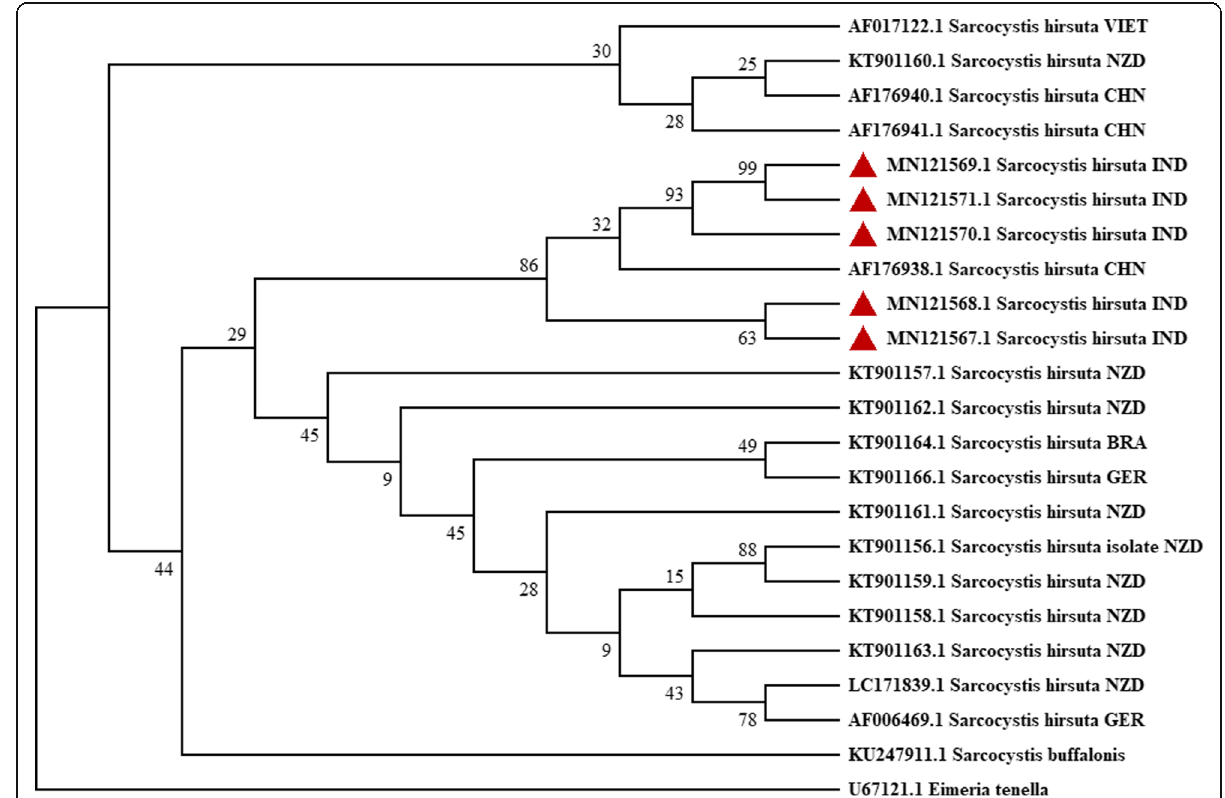
Fig. 2 Phylogenetic relationship of S. hirsuta isolates across the world based on 18S rRNA gene. All accession numbers correspond to different S. hirsuta isolates followed by their country of origin. The sequences generated in the present study are marked as a red triangle. CHN, China; GER, Germany; IND, India; NZD, New Zealand; VIET,